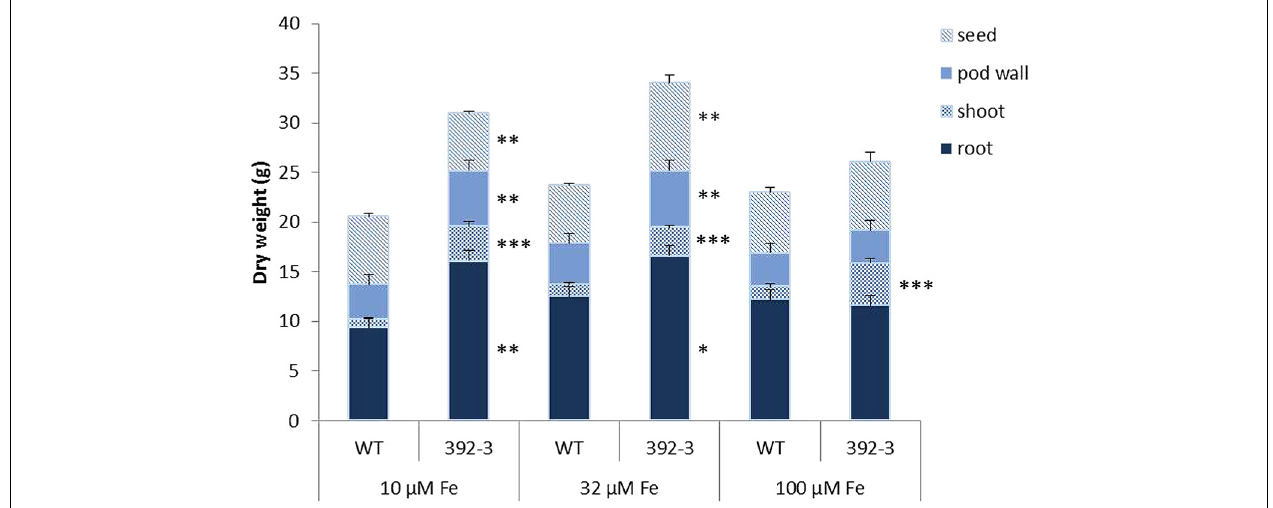
are the averages of at least five samples ± SE. Asterisks indicate that the means (betweenWT and 392-3 within tissue type) are different by theTukey